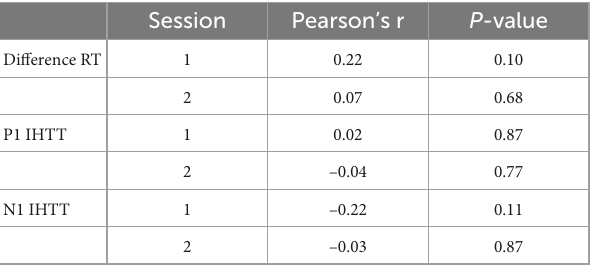
TABLE 6 Immediate Post-Concussion Assessment and Cognitive Testing (ImPACT) total symptom score and P1 and N1 interhemispheric transfer time (IHTT) correlations.